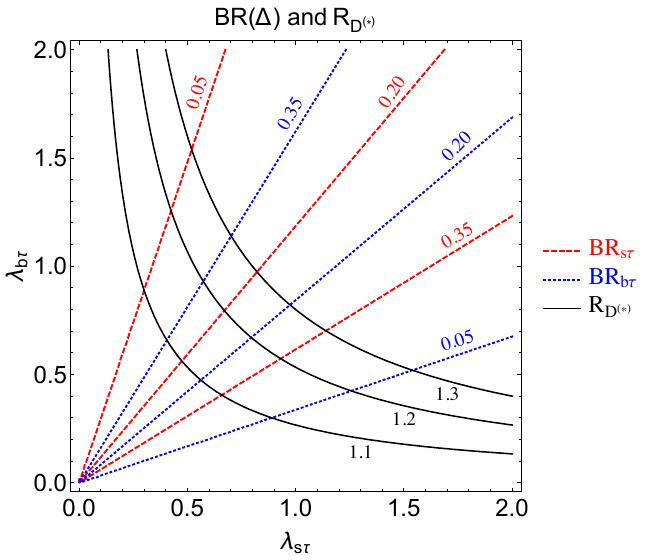
Figure 1 . A comparison of contours of R in black and red (blue),